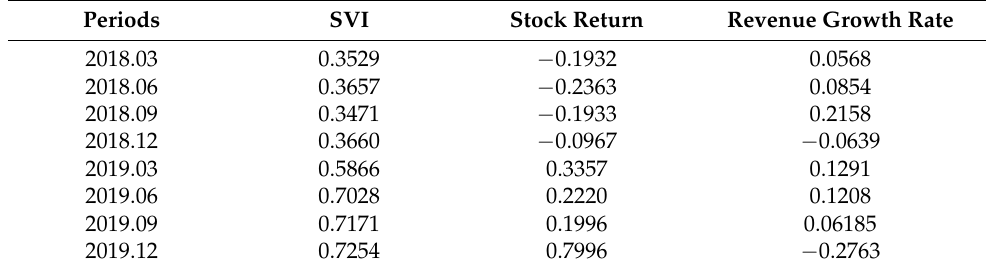
Table 4. “ g ” estimation results for each